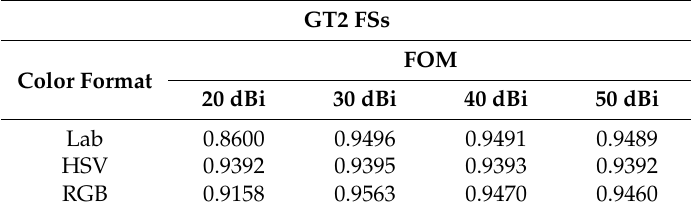
Table 9. FOM values achieved by GT2 FSs in images with Gaussian noise.